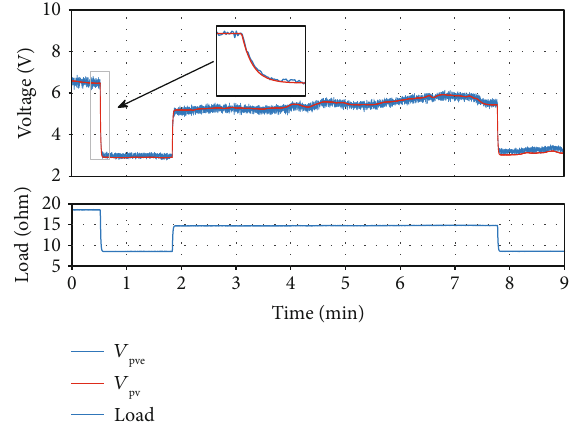
Figure 14: Proposed emulator test under load variation.